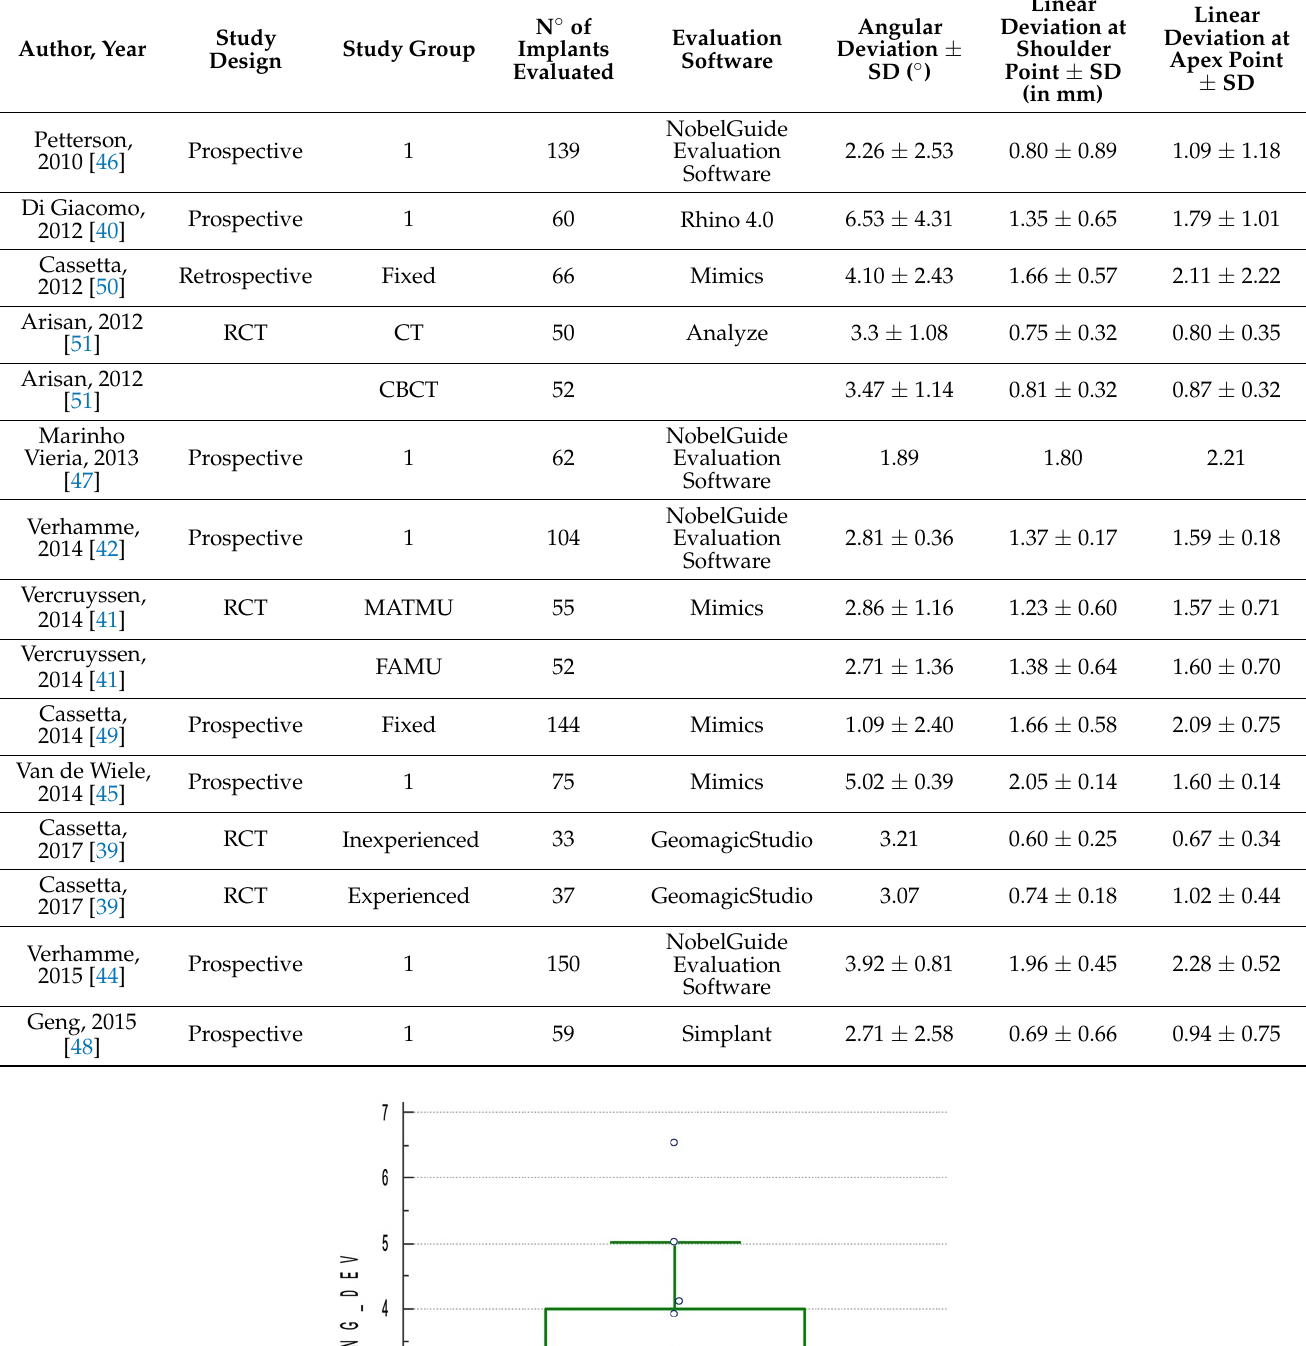
Table 2. Main characteristics of the included studies.